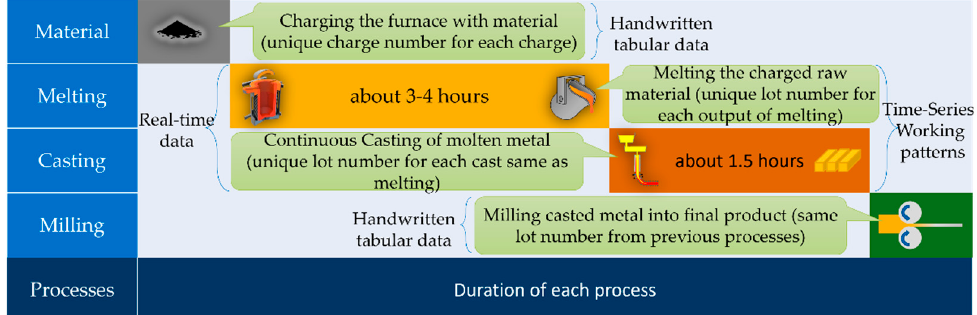
Figure 3. Overall process of metal